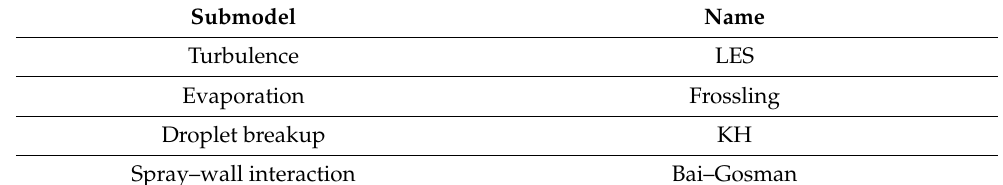
Table 1. Submodels used in this study.